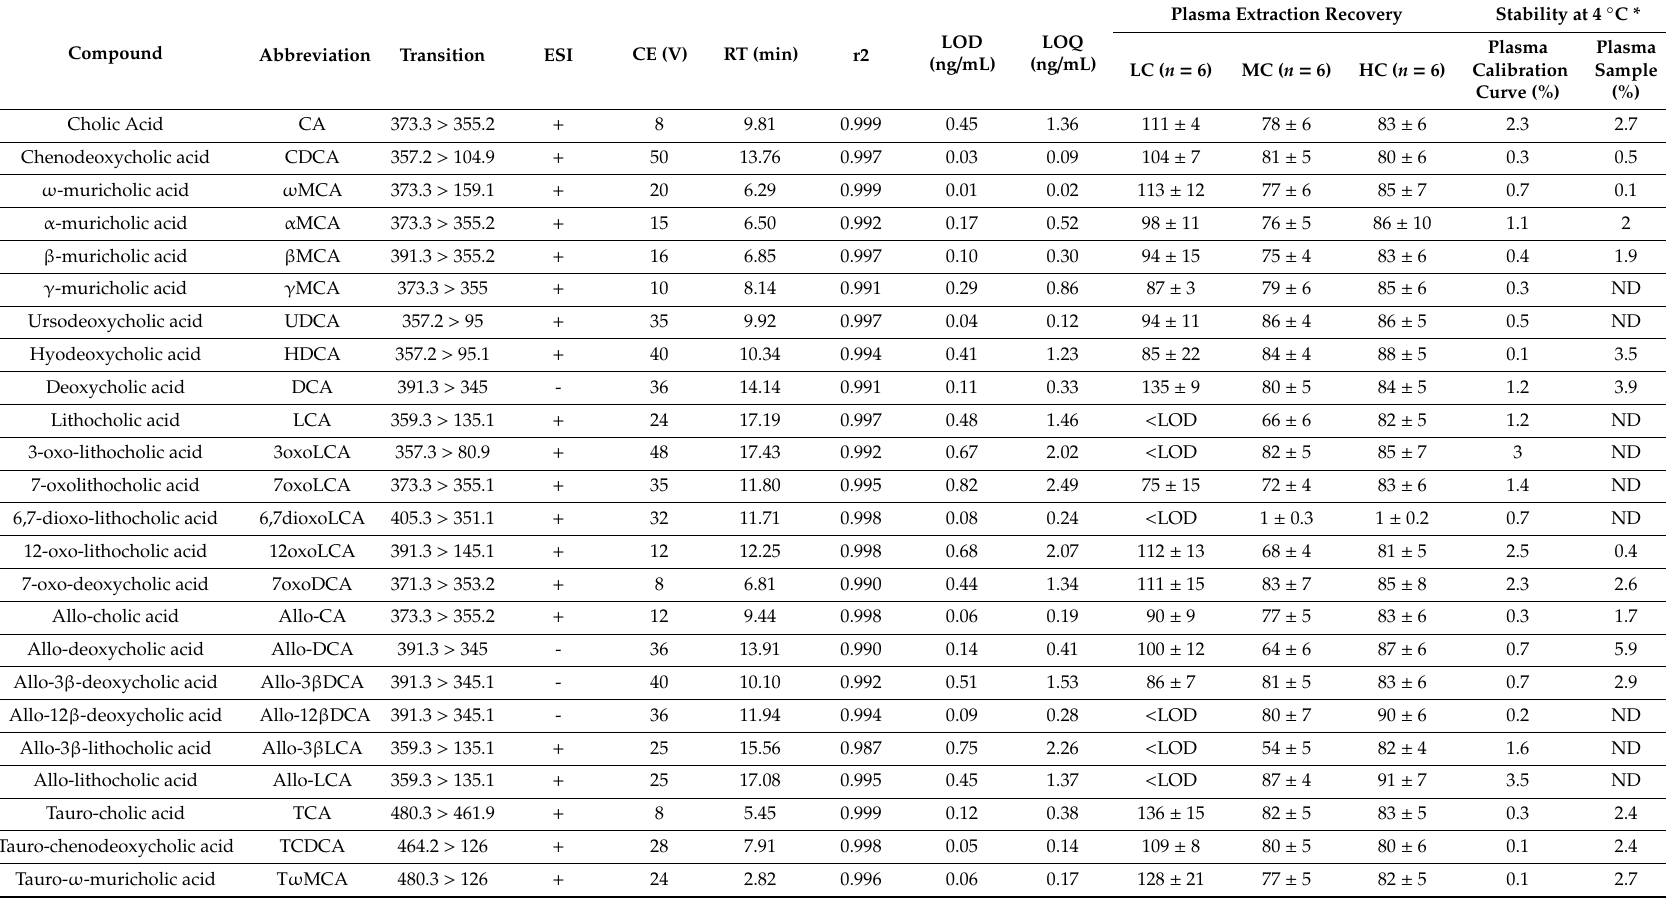
Table 1. Method characteristics and validation parameters for the quantification of bile acids in serum and plasma by LC-MS / MS. Abbreviations: CE: collision energy; RT: retention time; R2: linearity; LOD: limit of detection; LOQ: limit of quantitation; LC: low concentration; MC: medium concentration; HC: high concentration, ND: not